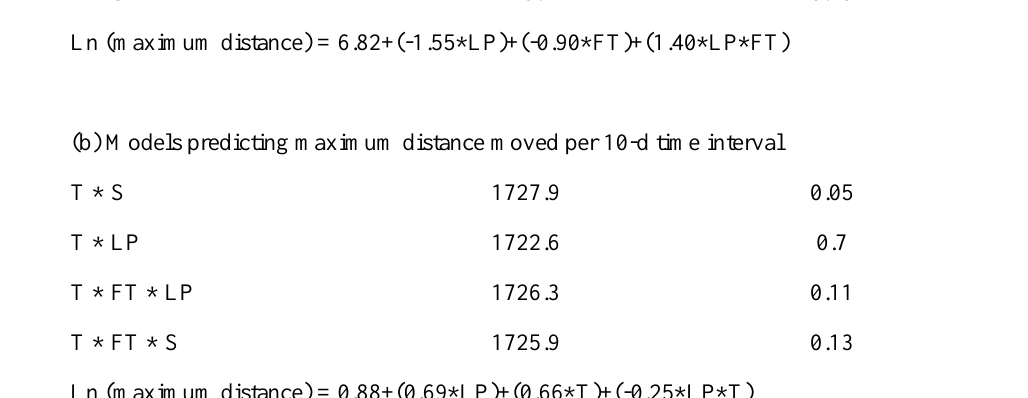
186.5 0.004 183.7 0.01 178 0.25 176.6 0.51 178.2 0.23